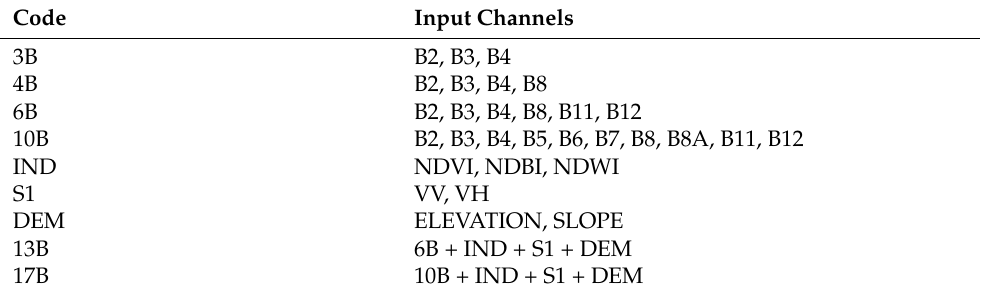
Table 1. Input band combination